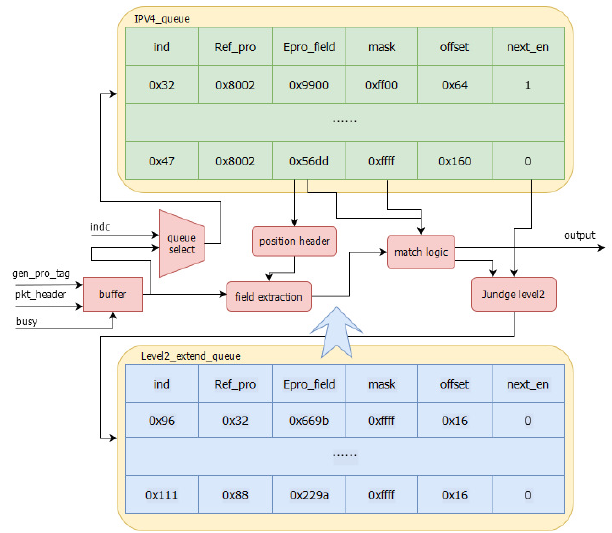
Figure 6. The extended protocol detection